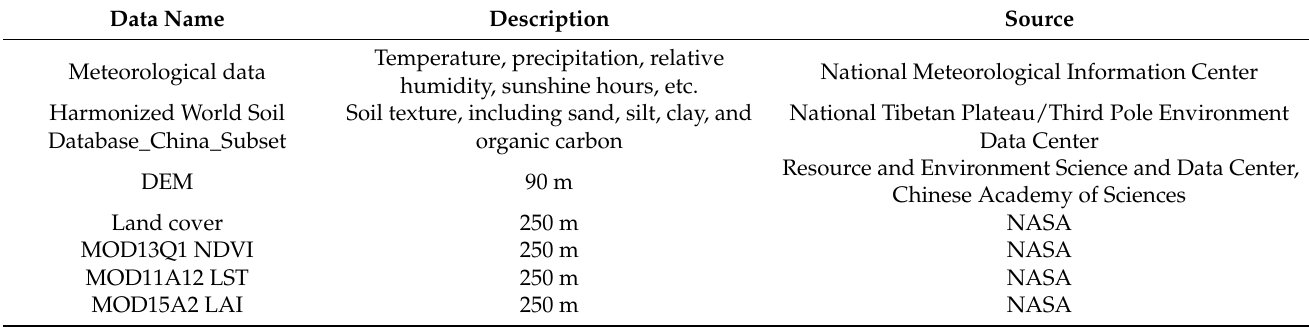
Table 1. List of